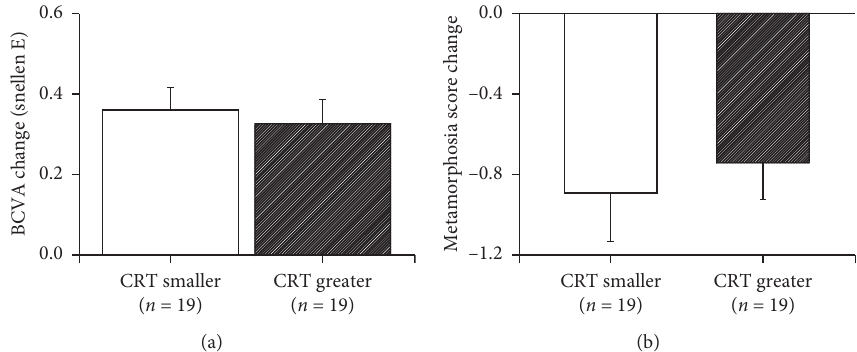
Figure 4: The final postpeeling BCVA improvements ( n � 19; 0.36 ± 0.06 �− 0.39 ± 0.09 LogMAR) and metamorphopsia reductions ( n � 19; − 0.89 ± 0.24) relevant to the group of patients’ retinas with the prepeeling less CRT ( < 500 μ m) did not significantly differ from those data ( n � 19; BCVA: 0.33 ± 0.06 � − 0.36 ± 0.08; metamorphopsia score: − 0.74 ± 0.18) relevant to the other group of patients whose retinas had the prepeeling greater CRT ( ≥ 500 μ